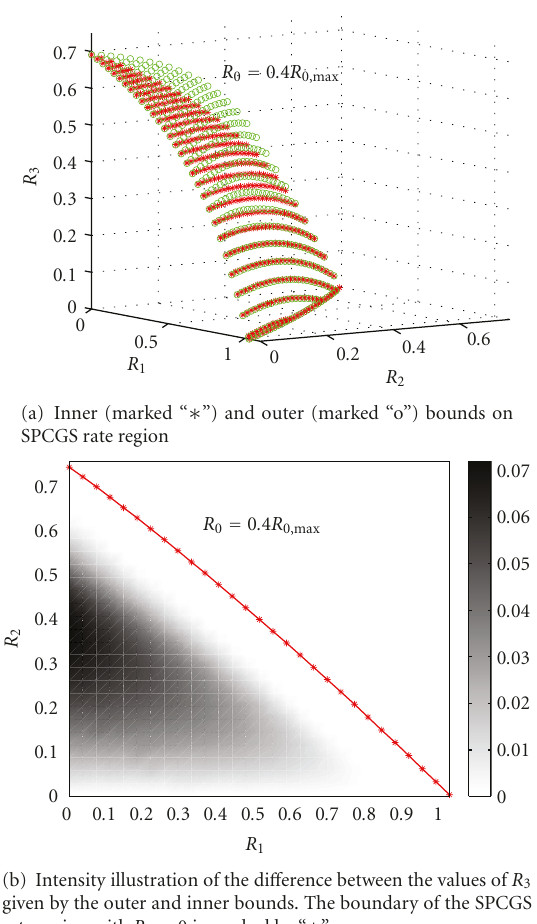
Figure 4: A comparison between the inner and outer bounds on the SPCGS rate region at R 0 = 0 . 4 R 0,max .